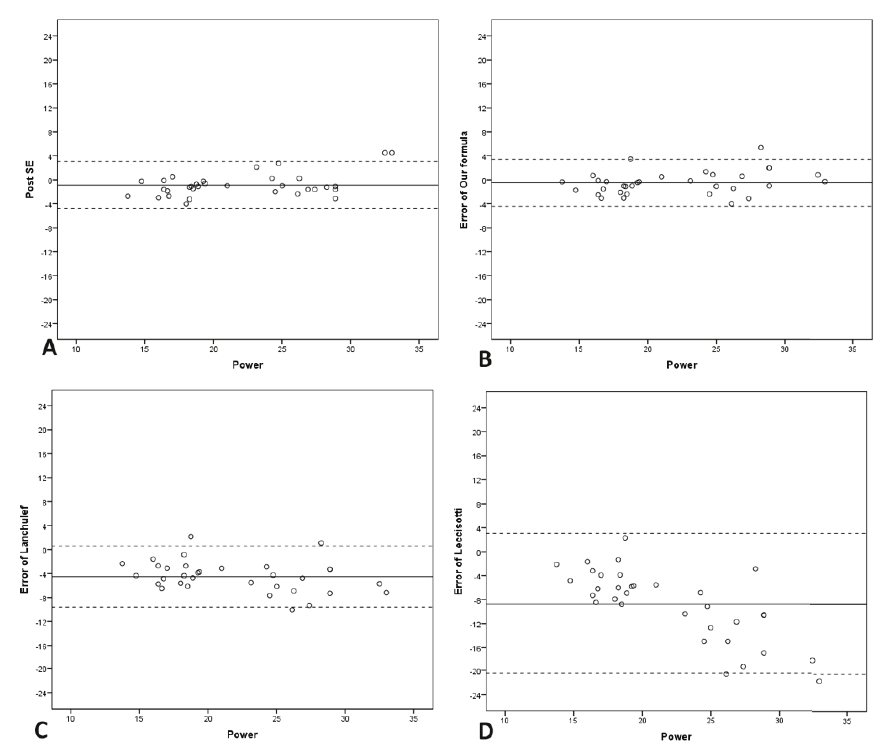
Figure 2. Scatter plots demonstrating postoperative spherical equivalent (SE) (A), the error of different formulas plotted against the calculated power based on the modified formula (B), Ianchulev (C), and Leccissotti